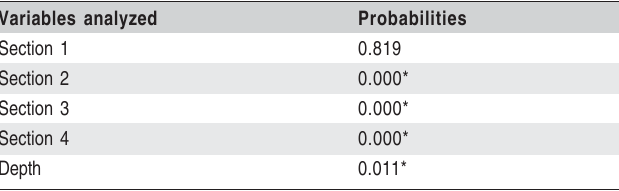
Table 3 – Comparison of groups A2 and